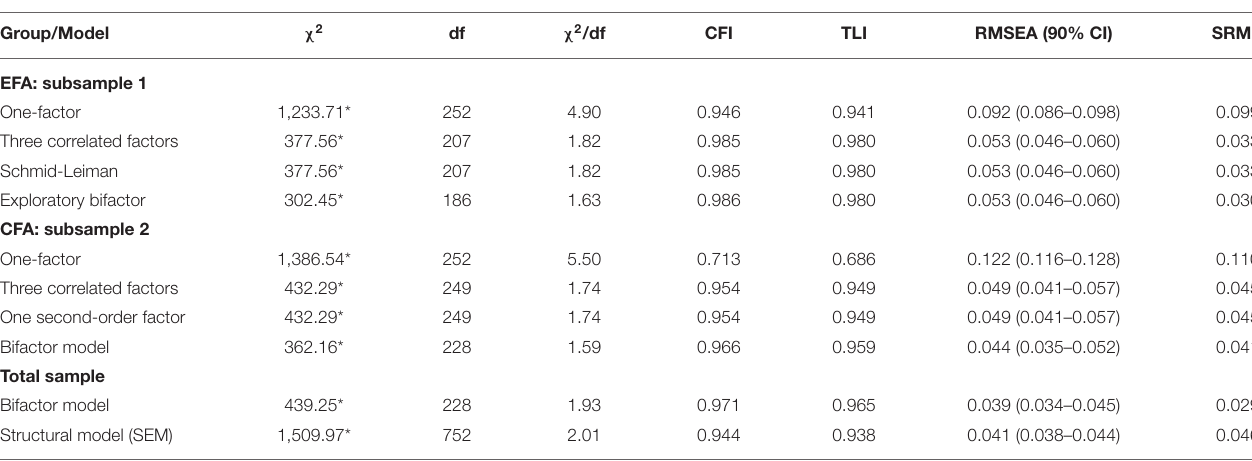
TABLE 4 | Fit indexes for the EFA, CFA, and SEM analyses.